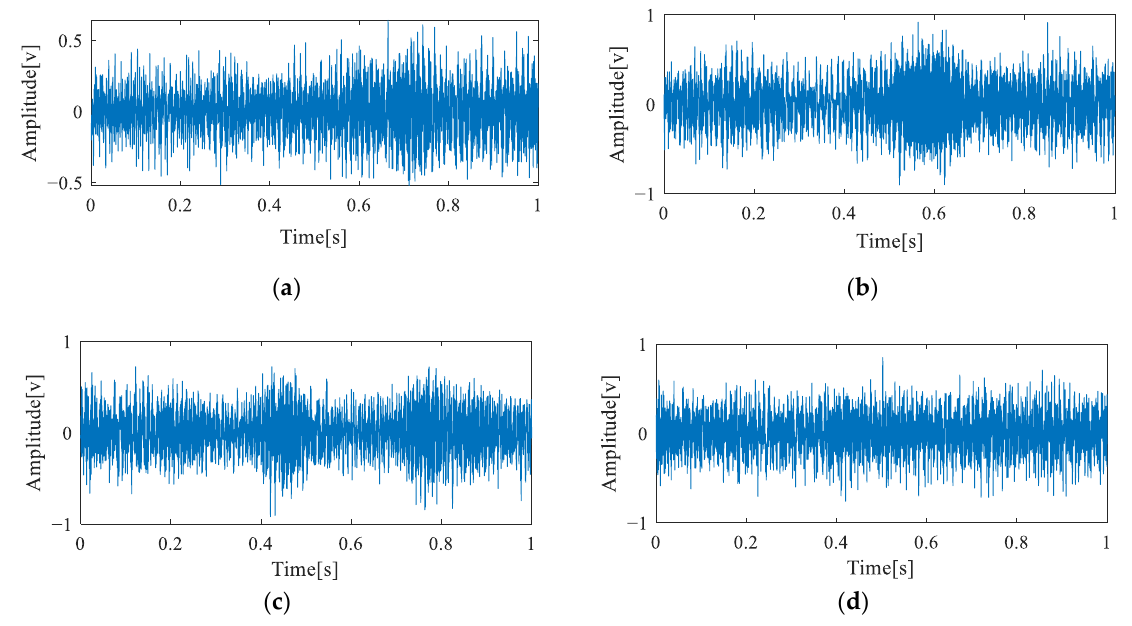
Figure 4. Original vibration signals of in-wheel motors with different states: ( a ) normal state; ( b ) inner race fault; ( c ) rolling element fault; ( d ) outer race fault.